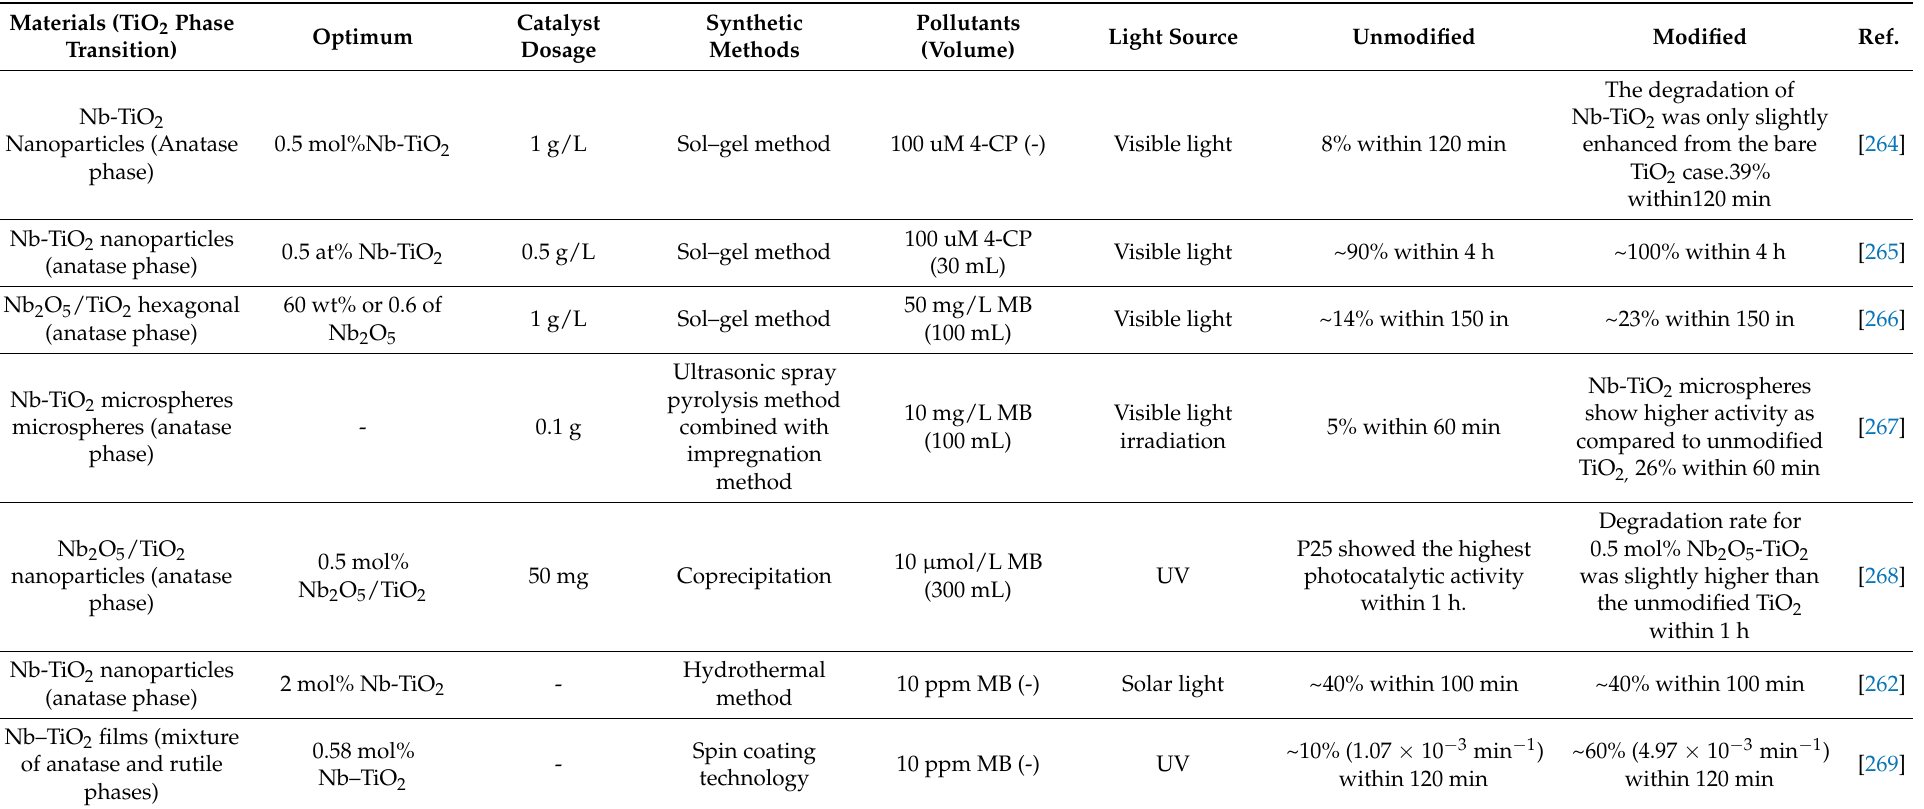
Table 12. Summary of recent progress on Nb-TiO 2 photocatalysts for organic pollutants